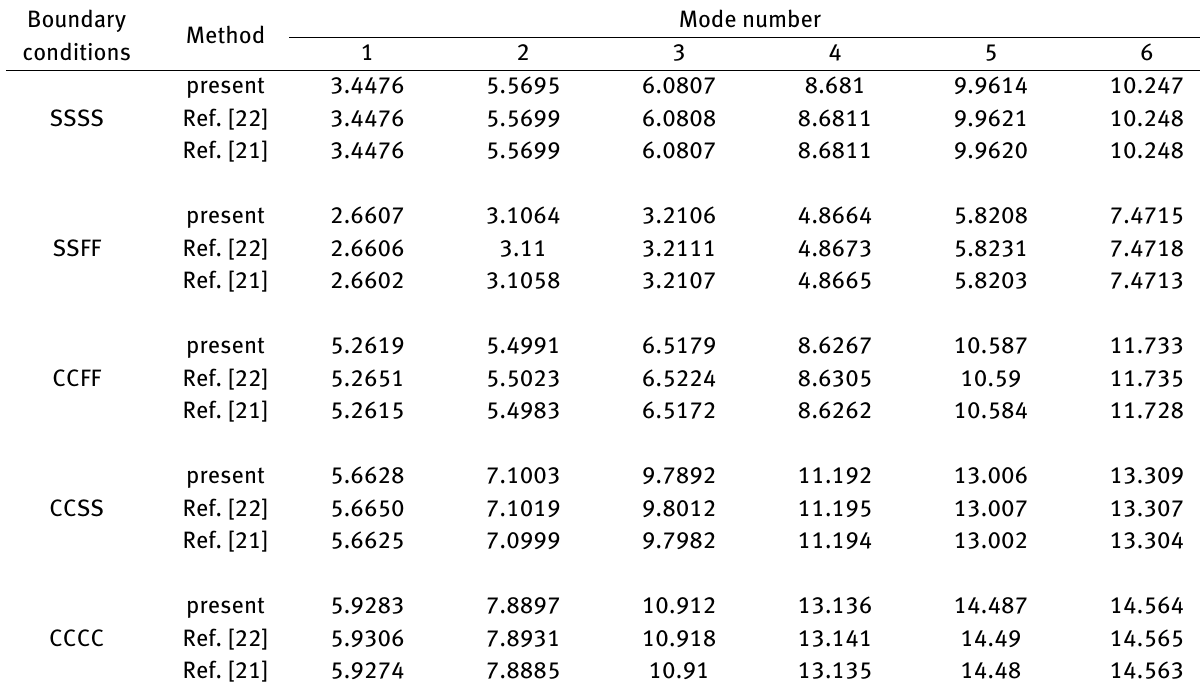
Table 4: Comparison of the frequency parameters Ω for a isotropic thick annular sector plate with different boundary conditions ( R 0 / R 1 = 0.4 , h / R = 1/6 , ϕ = π /2